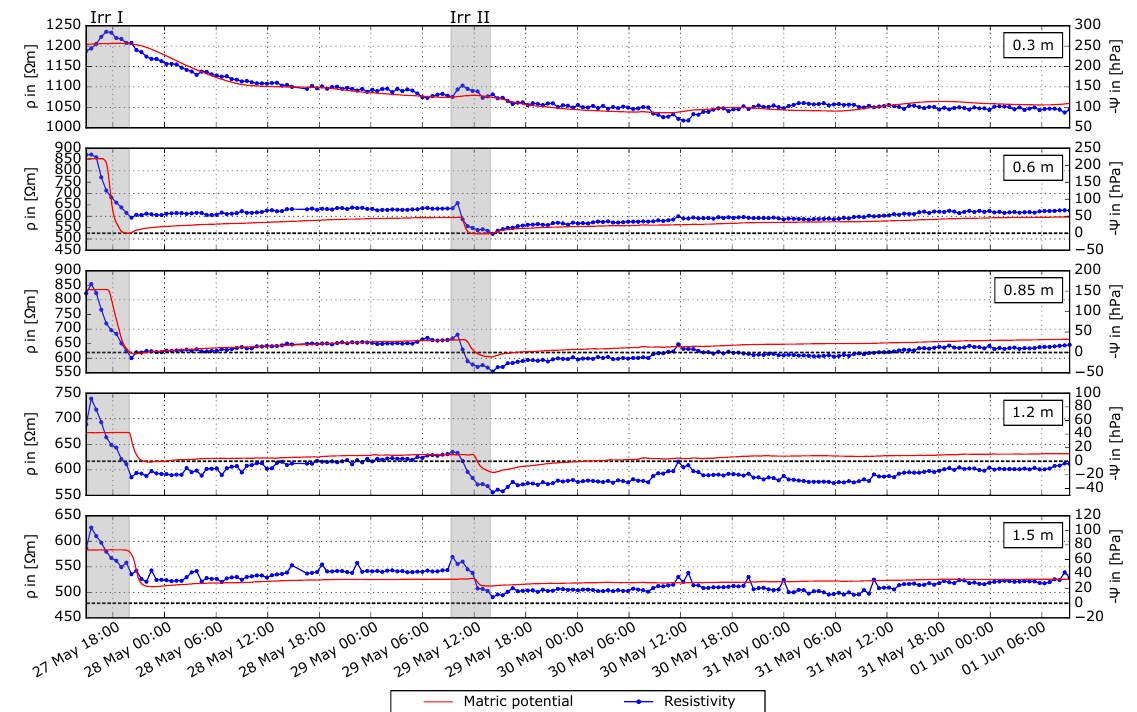
Figure 4. Variation of matric potential and co-located resistivity at different depths in 1.5m distance downslope of the irrigation area (bold dashed lines highlight the 0hPa level).